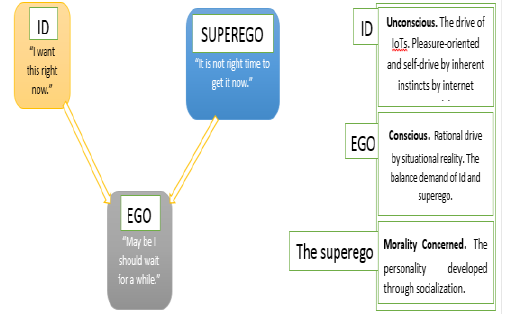
Figure 1 . psychoanalytic theory and internet